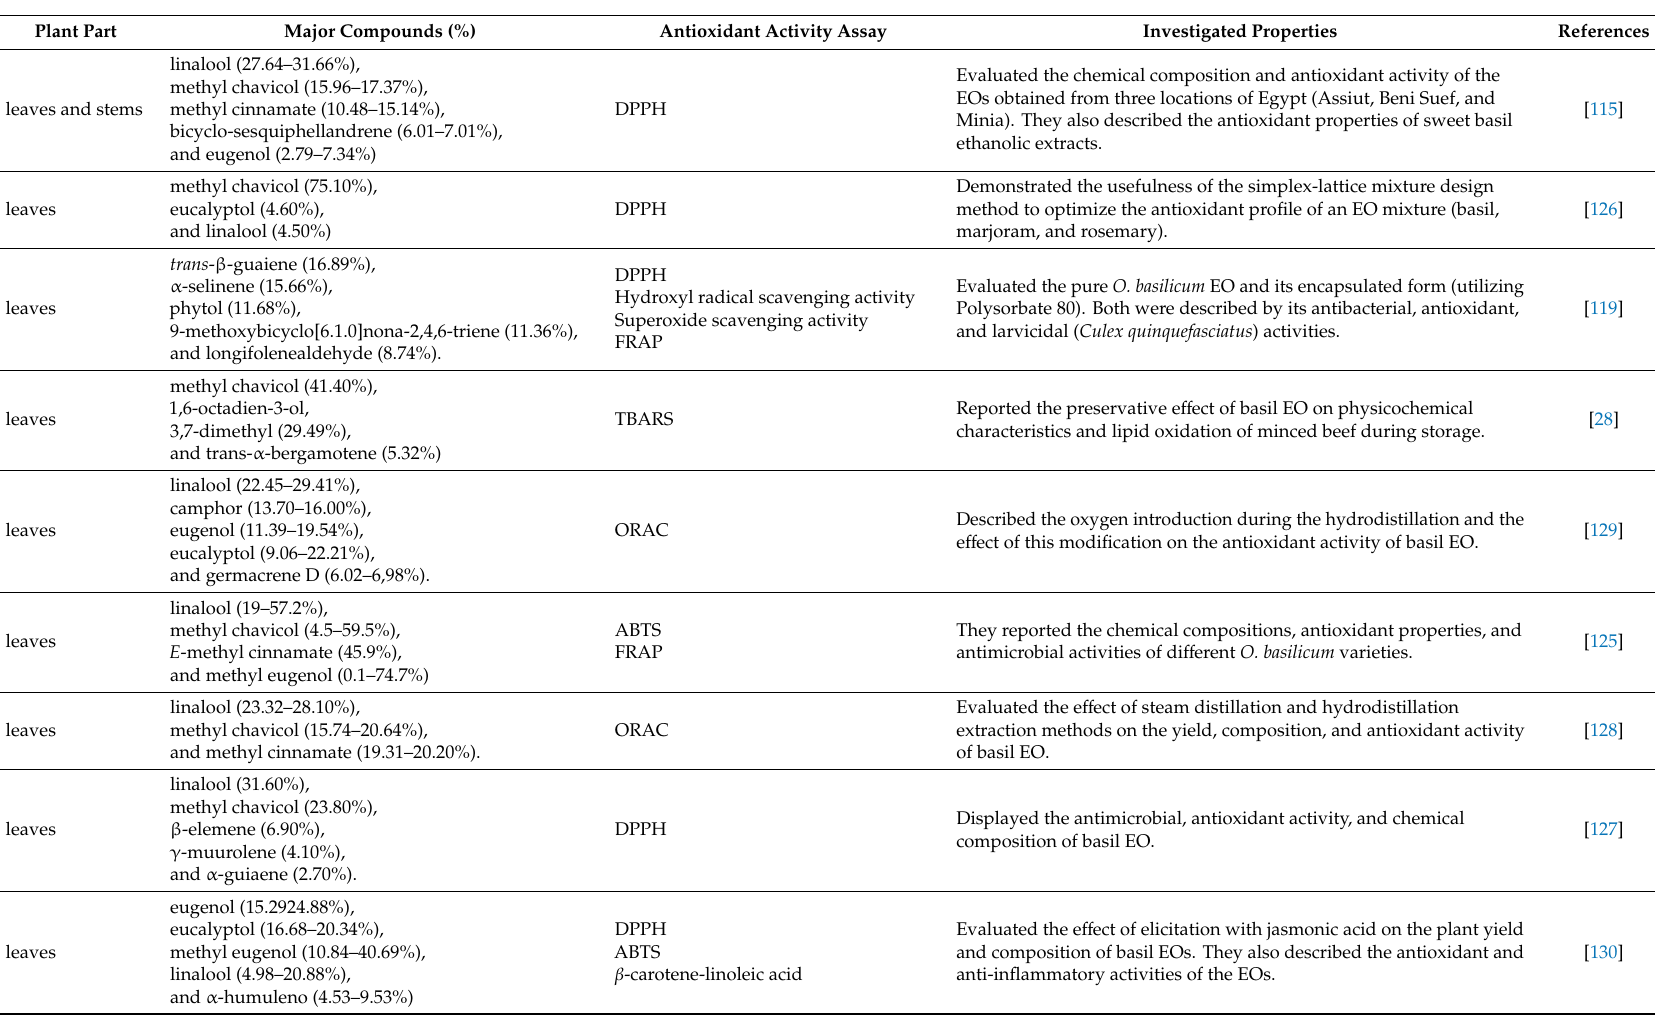
Table 3. Major natural compounds, methodologies applied to determine the antioxidant activity, and the investigated applications of Ocimum basilicum (Lamiaceae) EOs. Plant